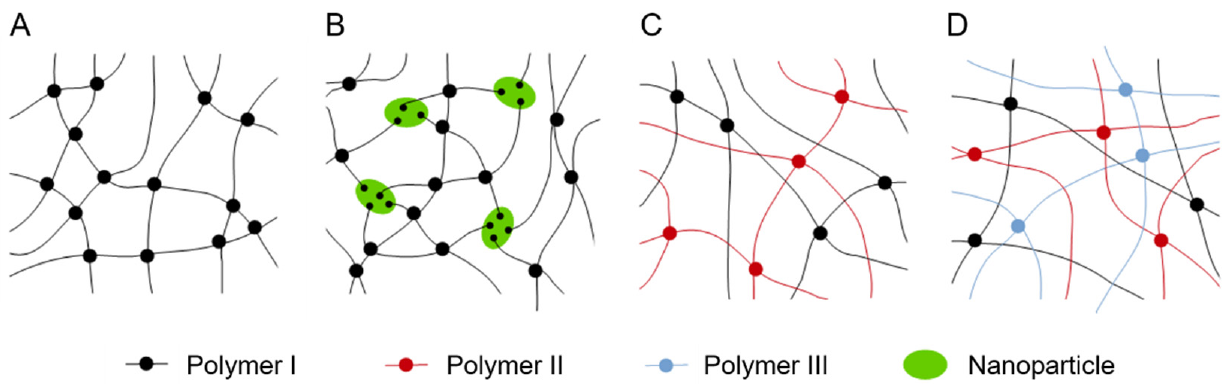
Figure 5. Schematic representation of hydrogel network structures. ( A ) Single network; ( B ) nanocomposite network; ( C ) double network; ( D ) triple network. Adapted from Peak et al. [64].